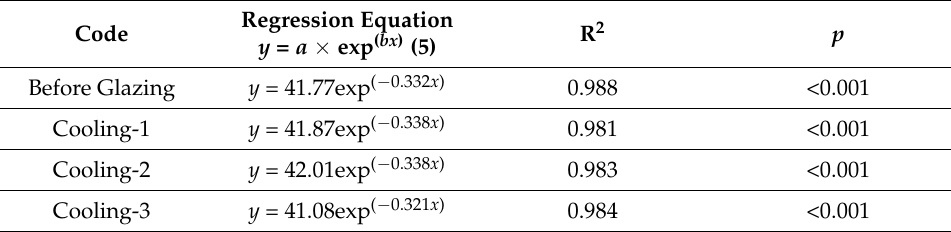
Table 5. Regression analysis of the relationship between the average transmittance (AT) and thickness for each group of the zirconia specimens.